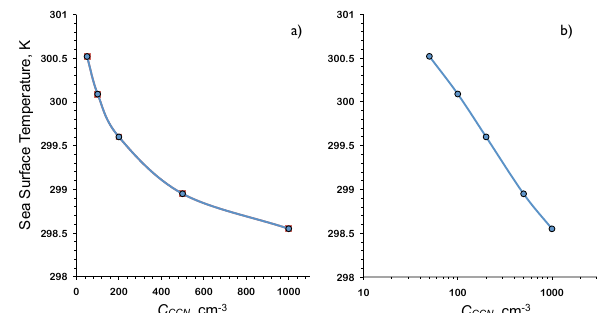
Fig. 2. Dependence of near-equilibrium SST on the CCN number concentration at 1% supersaturation plotted as (a) linear and (b) logarithmic